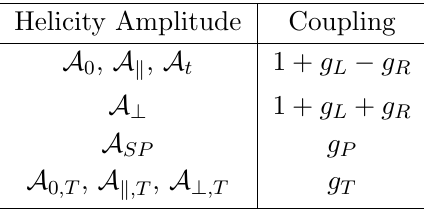
Table 4 . Contributions of the NP couplings to the various helicity